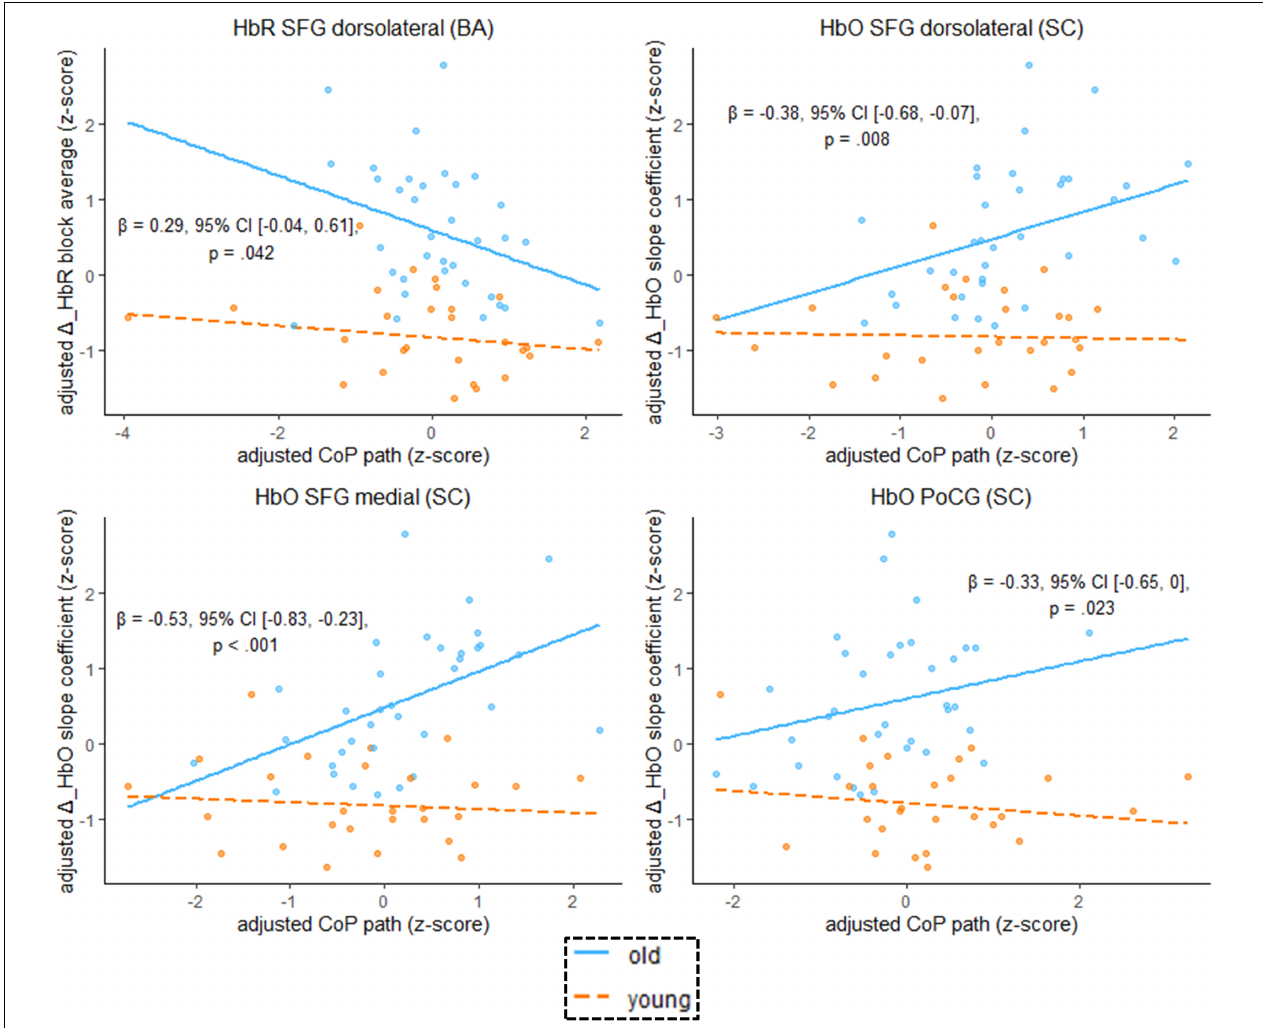
FIGURE 7 | Scatterplots with lines of best fit show the relation between balancing-induced neural activity in selected ROIs and wobble board CoP path length. Compared to Figure 5 , age group and an age group-by-hemodynamics interaction term were added as covariates to the linear model. The blue (orange) line of best fit can be interpreted as the unique effect of hemodynamics on balance performance exclusively for the older (younger) participants (simple slopes). Annotated regression coefficients show the between-group difference in simple slopes (i.e., the interaction effect). All p -values that are given in the figure are not adjusted for multiple comparisons (see Supplementary Table 4 , for FDR-corrected p -values). Abbreviations as in Figure 4